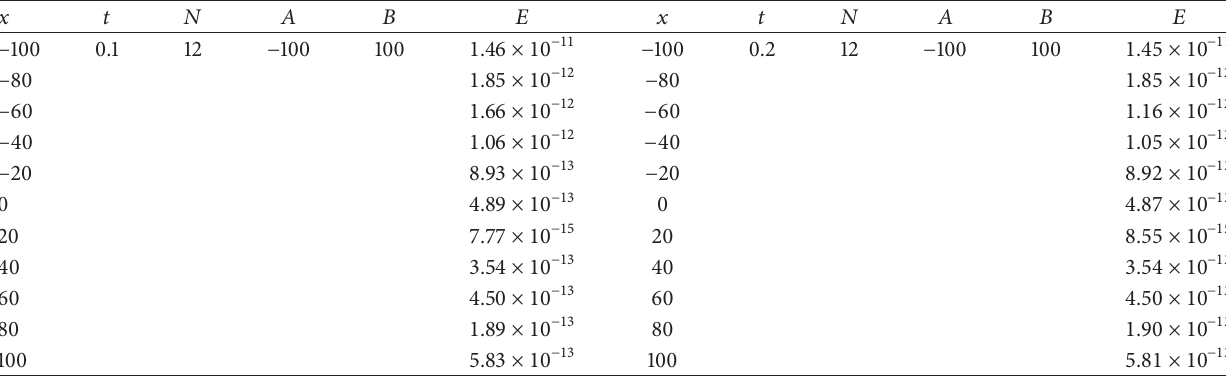
Table 4: Absolute errors with −𝜃 = 𝜗 = 1/2 , 𝑁 = 12 and various choices of 𝑥,𝑡 for Example 3 for 𝜏 = 0.5 , 𝜆 1 = 0.01 , and 𝑠 = 3 .